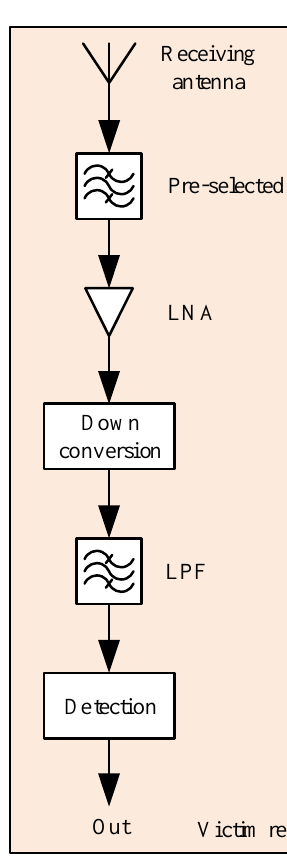
Figure 1. A co-located communication system that includes multiple transmitters and a victim re-